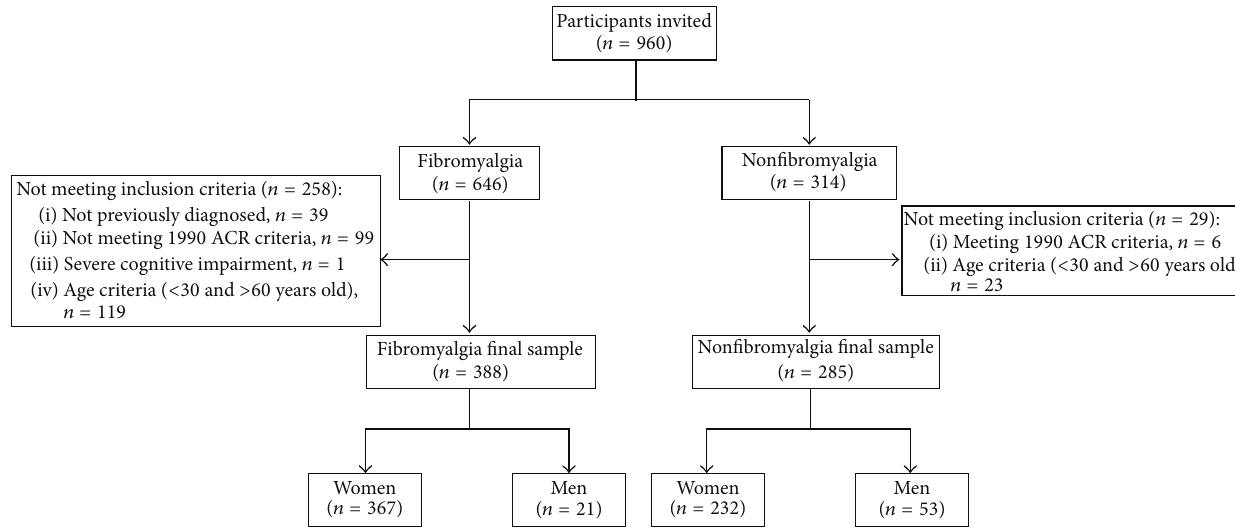
Figure 1: Flow diagram of